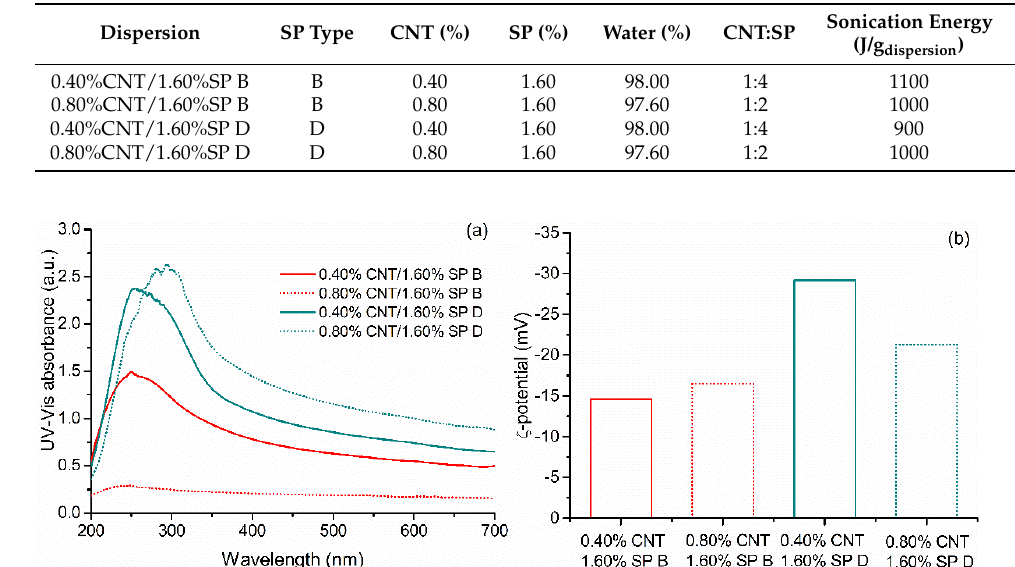
Table 4. CNT–SP proportions and total sonication energy for SP B and D refinements.